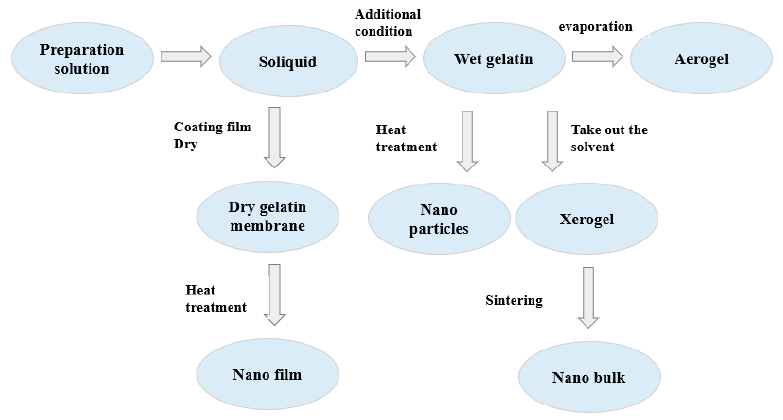
Figure 5. Nanofilm or nanoparticles by a sol–gel method.